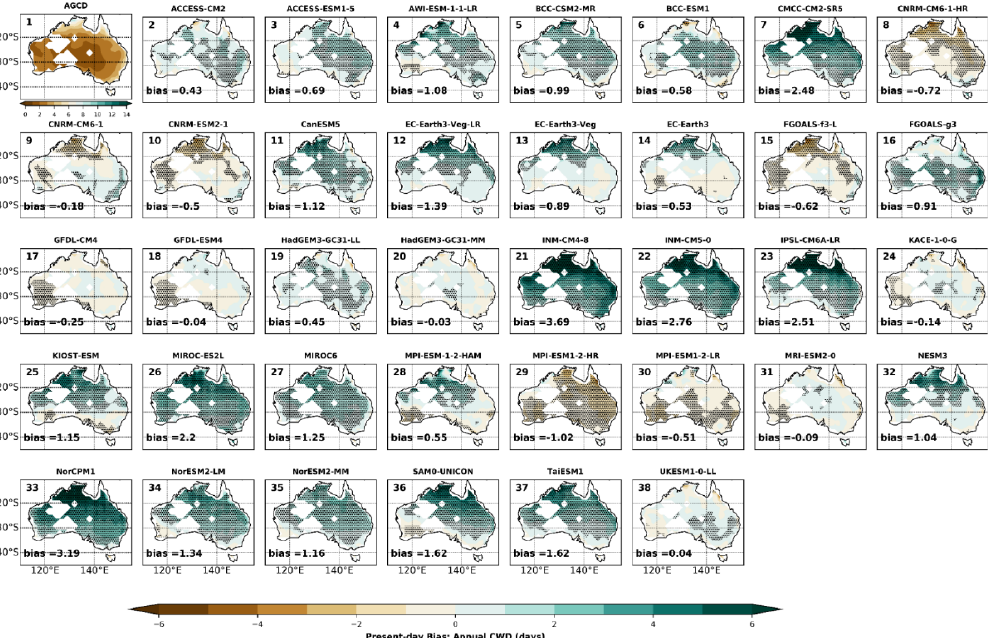
Figure 4. Climatological mean annual bias in consecutive wet days (CWD: days) relative to the Australian Gridded Climate Data dataset (AGCD; panel 1 ) for the individual CMIP6 GCMs (panels 2 – 38 ). Data spans 1951–2014. Stippling indicates statistically significant differences using a student’s t-test at the 95% confidence level. The white masks in part of the inland domain are the regions with no station data.